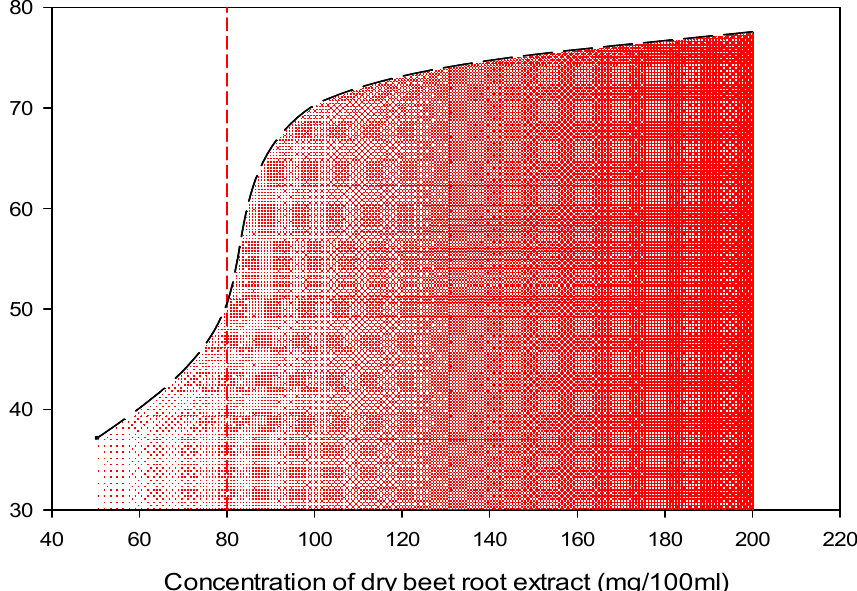
Figure 1. Antioxidant activity % of an IC50 at 80 mg/100 mL of DBRE (red dotted vertical line) dry beetroot